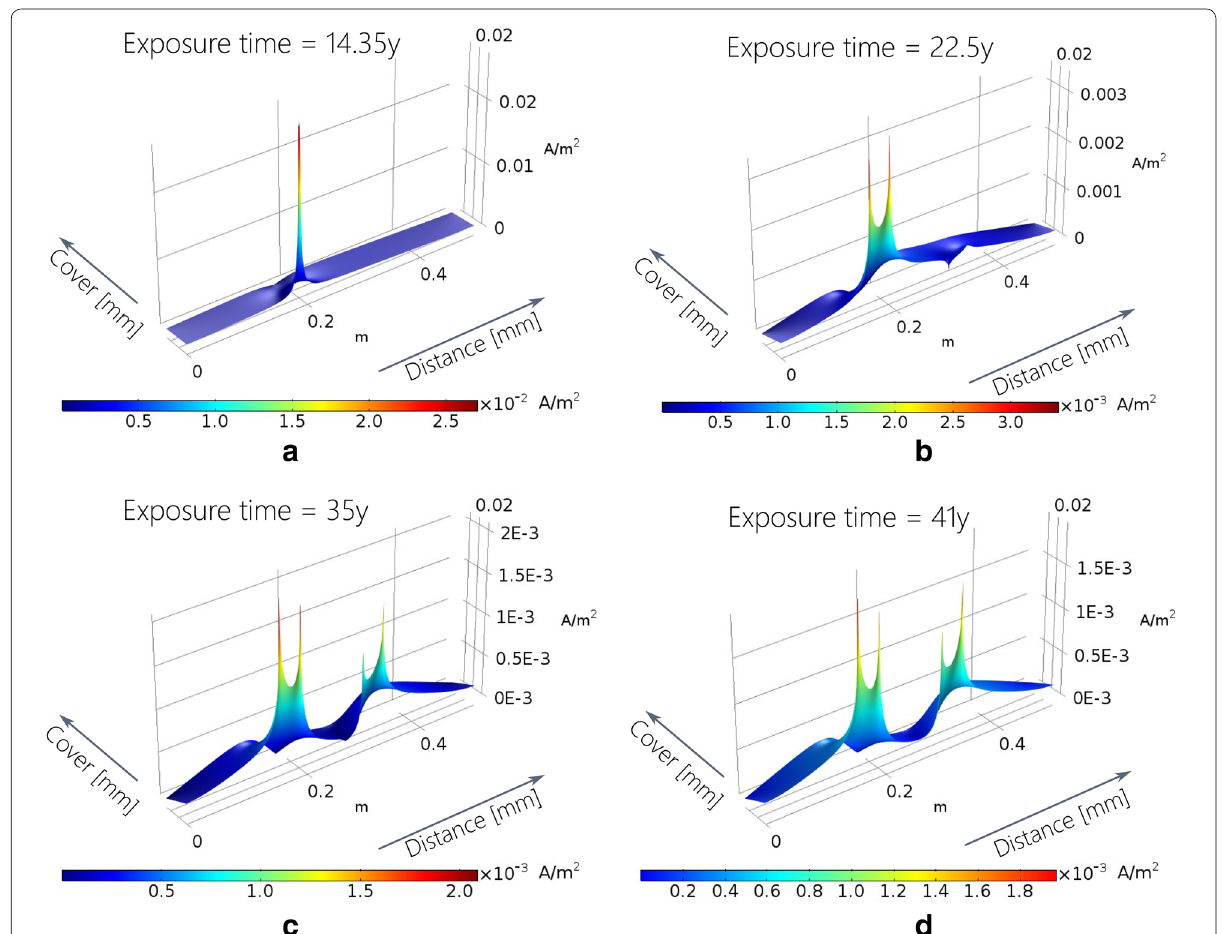
Fig. 7 Evolution of electrolyte current density with exposure time: a 14.35 years, b 22.5 years, c 35 years and d 41 years. The cover used in this simulation is 50 mm.